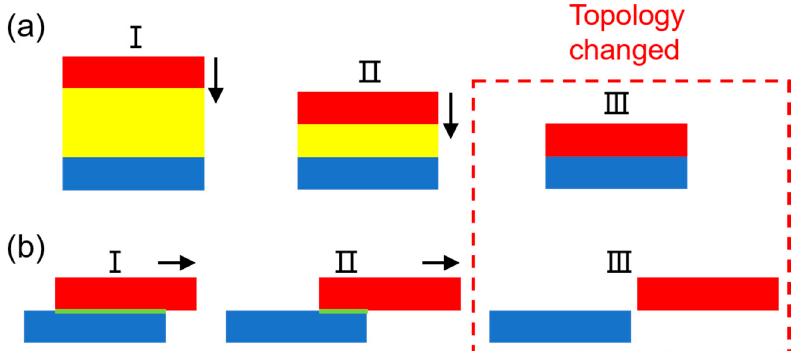
Figure 1. Practical movement of contact and sliding mode TENG makes the FEM geometry have topology change issues. ( a ) The topology of contact mode TENG changes due to the vanish of air layer (yellow) when upper tribo-material (red) moving from state I to III. ( b ) The topology of sliding mode TENG changes due to the vanish of the overlapped boundary (green) when upper tribo-material (red) moving from state I to III.